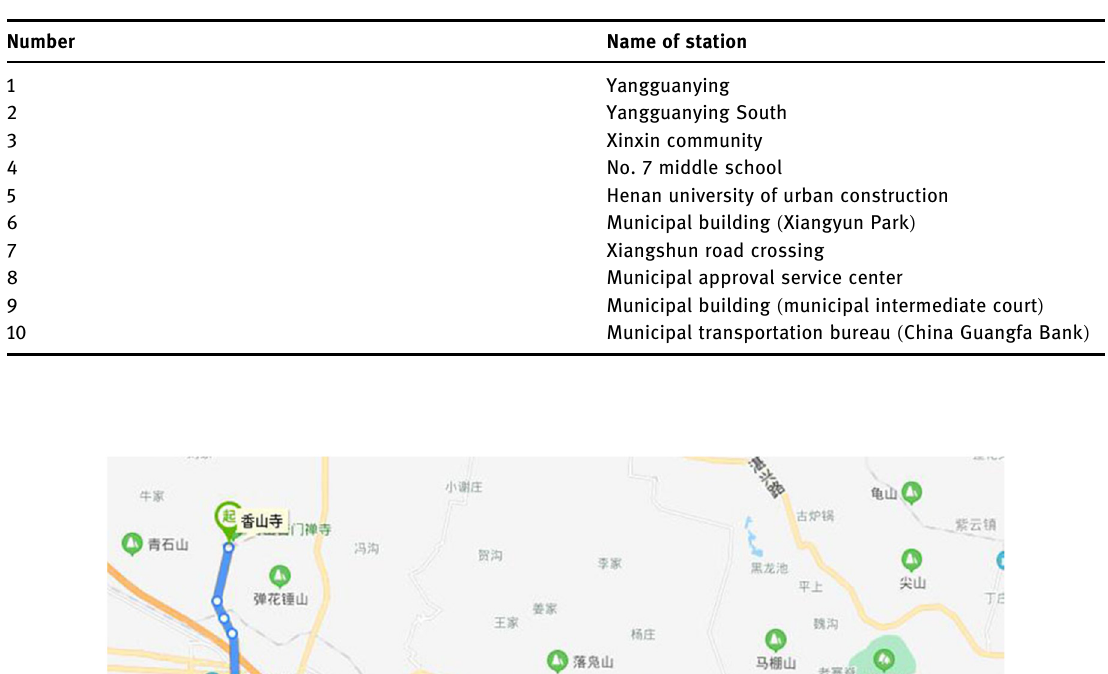
Table 2: Road section for study